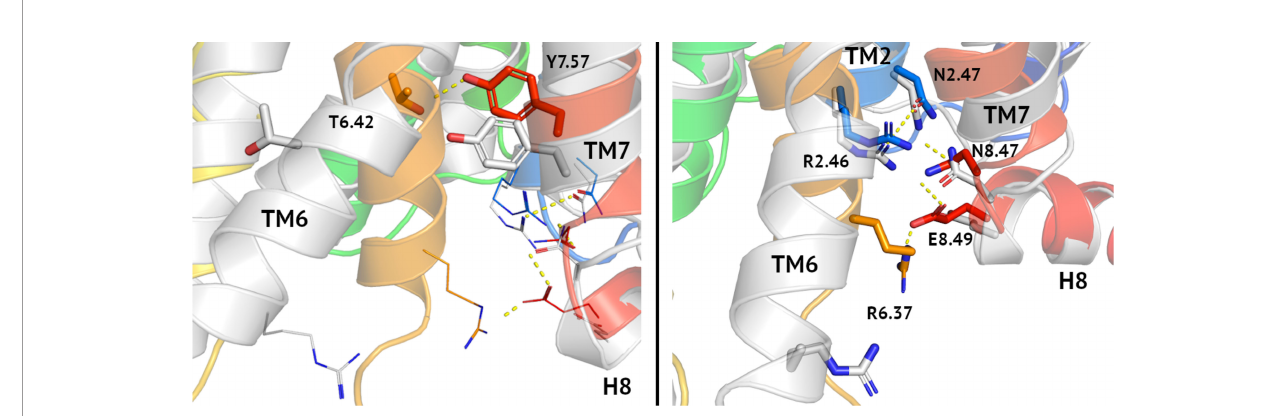
FIGURE 1 | Tyrosine toggle switch in VPAC1. Comparison between inactive (blue-to-red) and active (grey) conformations of VPAC1 in the region of tyrosine toggle switch (left) and the adjacent TM2-TM7-H8-TM6 hydrogen bond network (right). Hydrogen bonds were depicted as yellow dashed lines. Both, the tyrosine toggle switch and the adjacent hydrogen bond network change signi fi cantly during the receptor activation, mostly due to the TM6 bending and its counterclockwise rotation. Only N2.47-R2.46 interactions (right) were left in the active conformation of the receptor in this region comparing the inactive one.